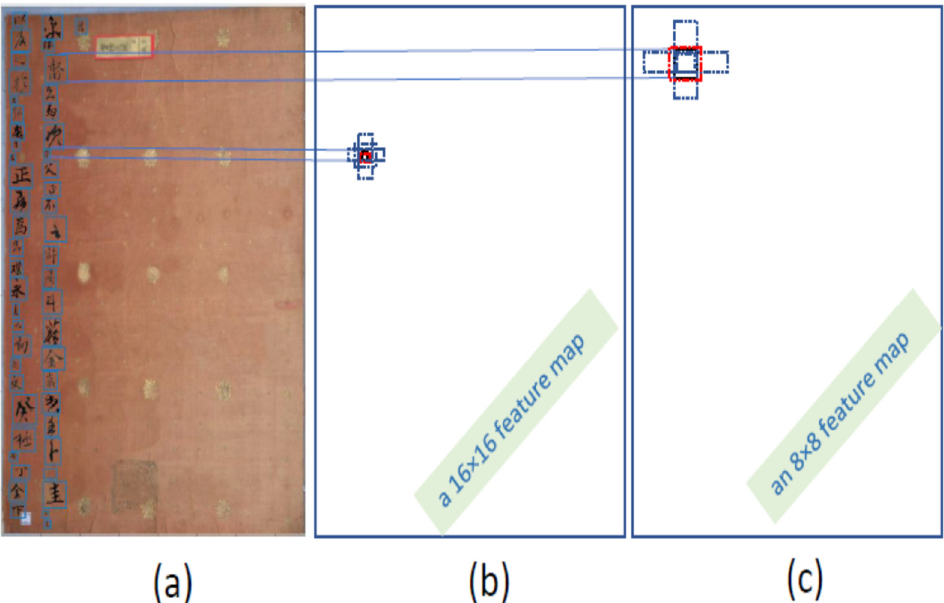
Figure 5. The process of multi-scale character detection: ( a ) image with ground truth boxes; ( b ) a 16 × 16 feature map with higher resolution detects a smaller character (red bounding box); ( c ) an 8 × 8 feature map with lower resolution detects a larger character (red bounding box). Over each feature map, there are a number of default boxes (dotted ones) at the given position, and the red box means that it is the proper one for character